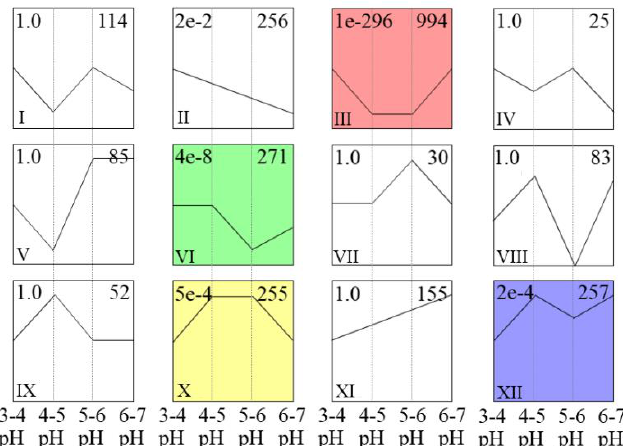
Figure 6. Comparison of DEG profiles in response to acid stress as determined by STEM clustering. For each profile, the top-left number indicates the p -value, the bottom-left number indicates the profile ID, and the top-right number indicates the genes assigned to this profile. The color profile indicates p < 0.05.